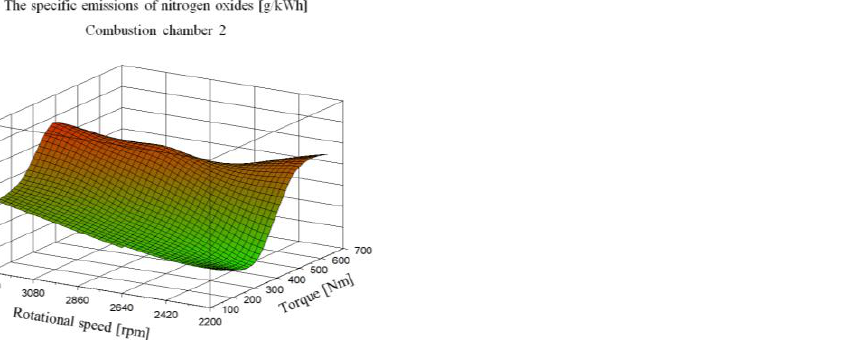
Figure 24. The nitrogen oxides emission of the engine equipped with the combustion chamber 2.